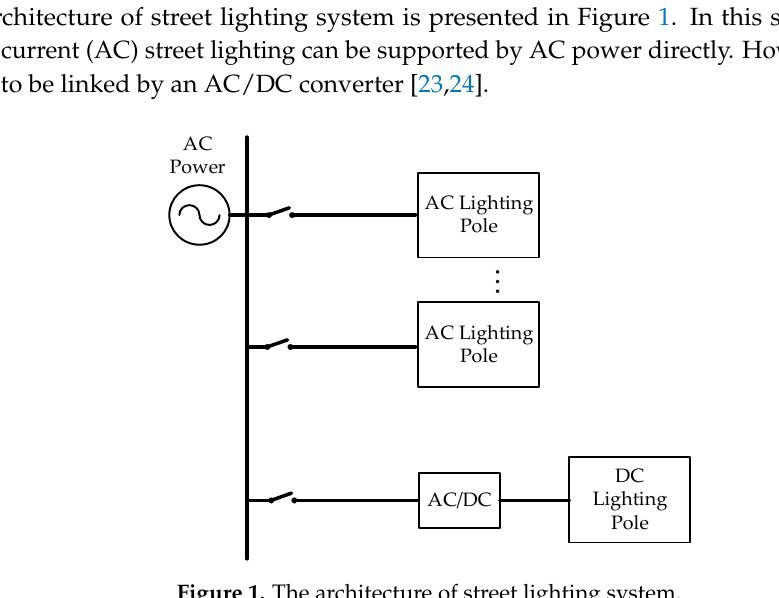
Figure 1. The architecture of street lighting system.